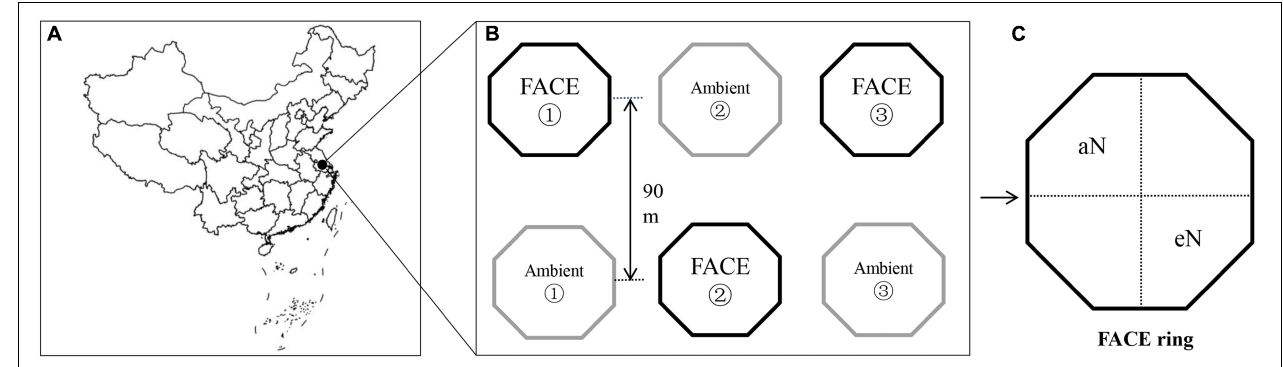
FIGURE 1 | Sampling site diagram of japonica rice WuYunJing from the free-air CO 2 enrichment (FACE) system (B,C) in Yangzhou city, Jiangsu, China (119 ◦ 42 (cid:48) 0 (cid:48)(cid:48) E, 32 ◦ 35 (cid:48) 5 (cid:48)(cid:48) N) (A)